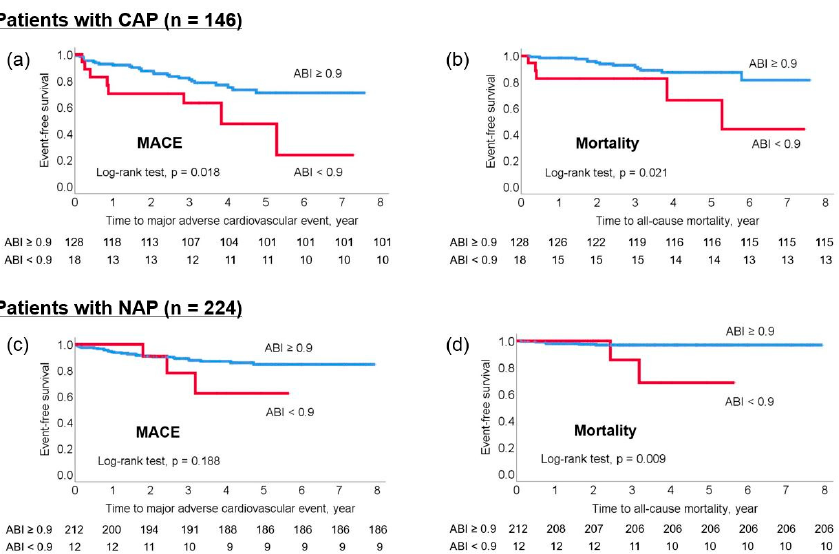
Figure 3. Kaplan–Meier survival analysis. ( a ) MACE and ( b ) all-cause mortality by low ABI in patients with CAP. ( c ) MACE and ( d ) all-cause mortality by low ABI in patients with NAP. ABI, ankle-brachial index; CAP, complex aortic plaque; MACE, major adverse cardiovascular event; NAP, non-stenotic relevant artery plaque.